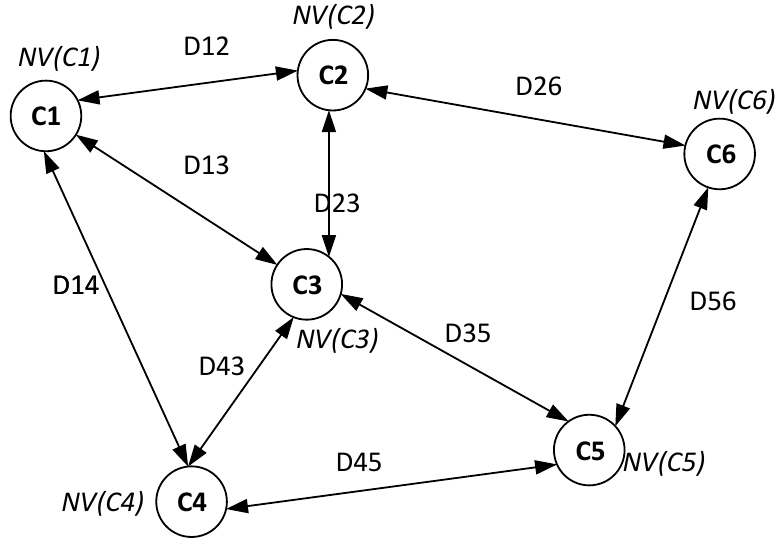
Figure 12. Illustration of a network model with six cluster